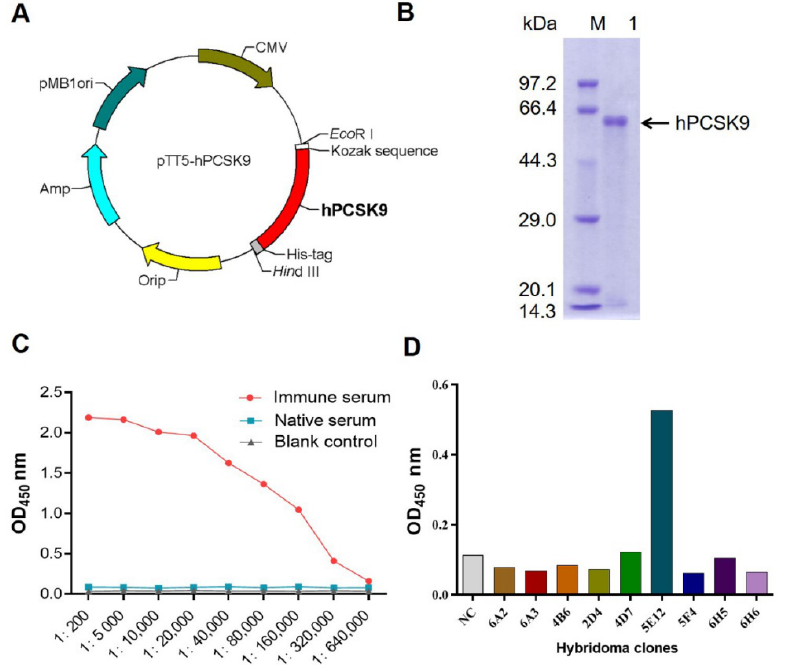
Figure 1. Generation of murine mAb against hPCSK9 protein. ( A ) Schematic representation of plasmid expressing hPCSK9. Kozak, Kozak consensus sequence; hPCSK9, the full-length sequence of human PCSK9 (GenBank accession number: NM_174936.3). ( B ) 10% ( w / v ) SDS-PAGE analysis of purified hPCSK9. M, molecular weight marker; Lane 1, purified hPCSK9 protein. There was a major band of 62 kDa corresponding to the catalytic and C-terminal domains of hPCSK9. ( C ) Serum titration after immunization with hPCSK9. The immune serum (antiserum) from mice immunized with hPCSK9 was titrated in dilutions from 1:200 to 1:640,000 and tested for antigen specificity by ELISA. Native mouse serum (pre-immune serum) was used as a negative control. ( D ) Screening of positive hybridoma clone secreting mAbs against hPCSK9 by ELISA. Cell culture medium was used as the negative control